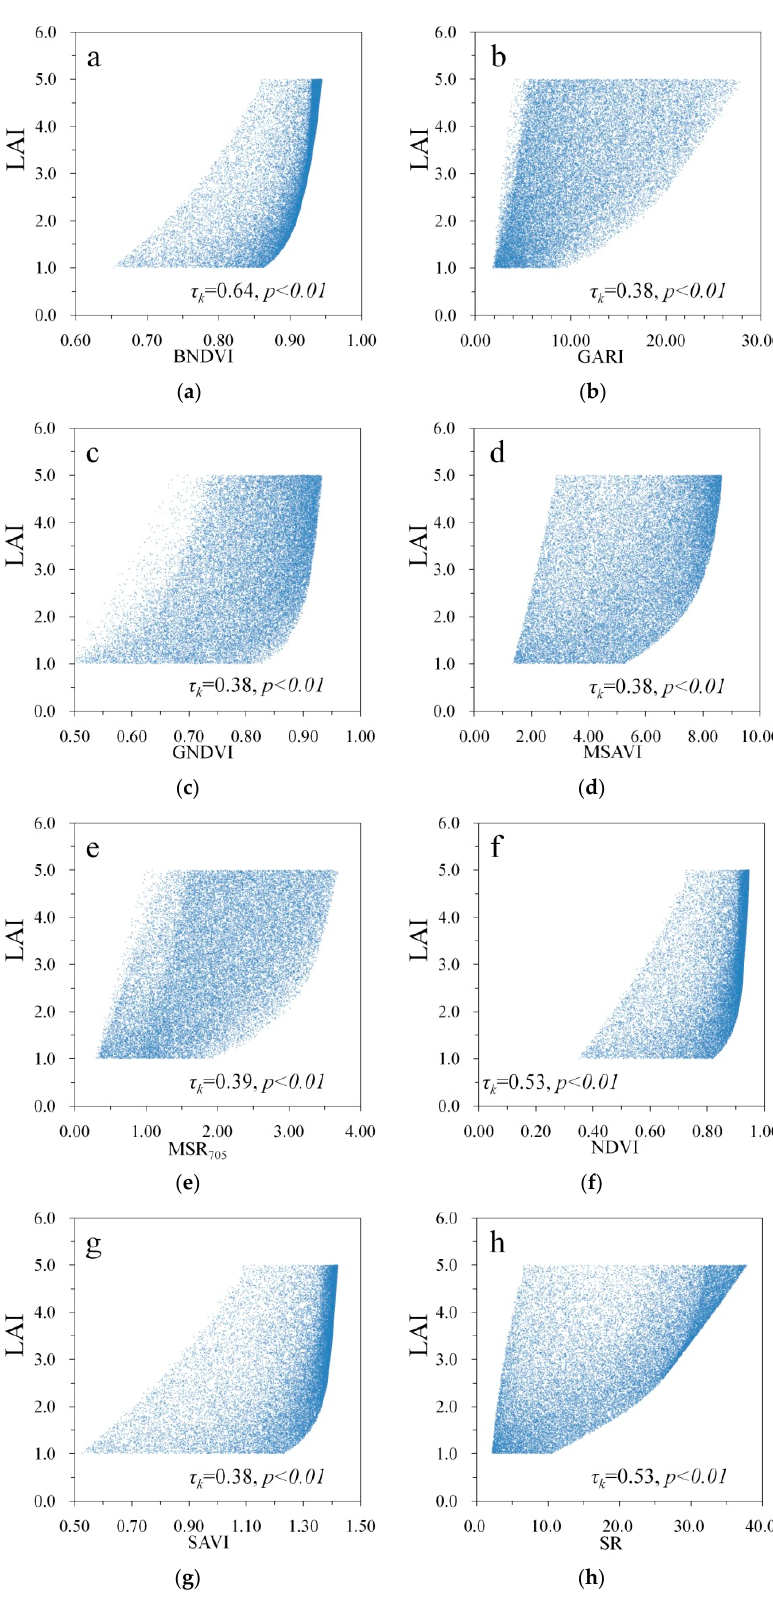
Figure 5. Correlation between LAI and the selected vegetation indices from imaging spectroscopy data: ( a ) BNDVI, ( b ) GARI, ( c ) GNDVI, ( d ) MSAVI, ( e ) MSR 705 , ( f ) NDVI, ( g ) SAVI, ( h ) SR. Kendall’s correlation coefficient τ k and the significance level p are given in each plot.